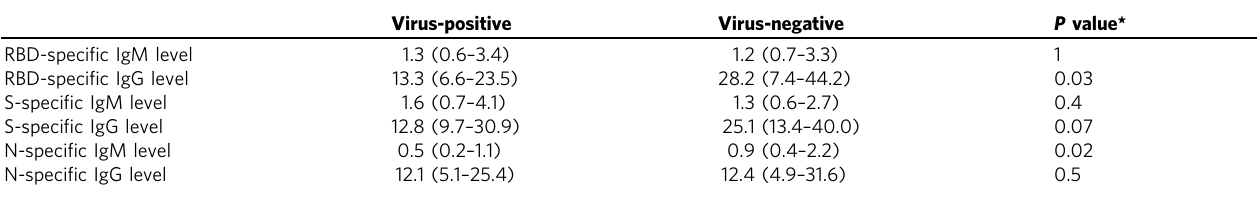
Table 3 Comparison of the SARS-COV-2-speci fi c antibody levels between SARS-CoV-2 RNA-positive and -negative patients.